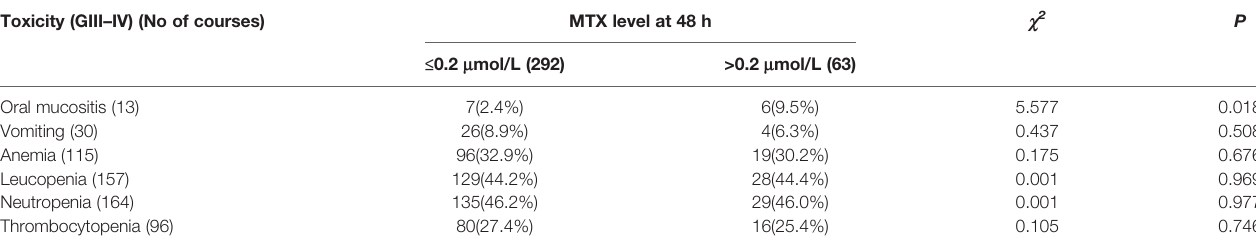
TABLE 3 | The relationships between MTX level at 48 h and HD-MTX-related toxicities. Toxicity (GIII – IV) (No of courses)